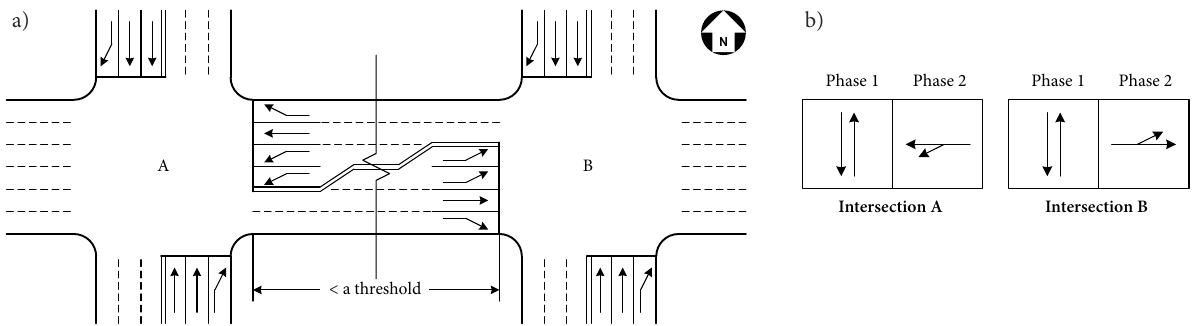
Figure 1. Case 1 of paired four-leg intersections: a – geometry design; b – signal phasing